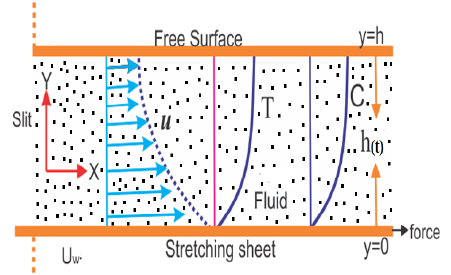
Figure 1. Illustrates the physical geometry of the used model.